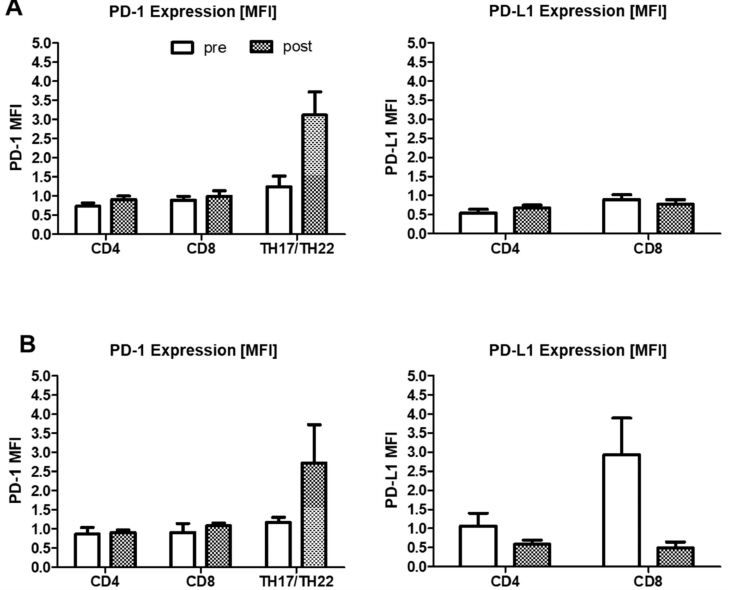
Figure 8. Flow cytometric analysis of CD4 + and CD8 + T cell subsets in PBMC from OSA patients before and after PAP treatment divided by initial severity of monocyte alteration. ( A ): PD-1